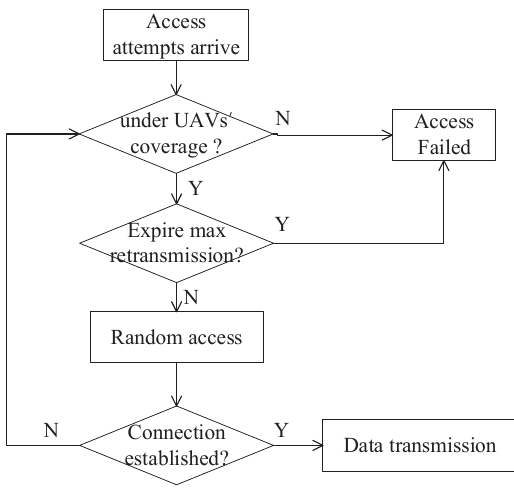
Figure 4. Connection establishment between sensor devices and